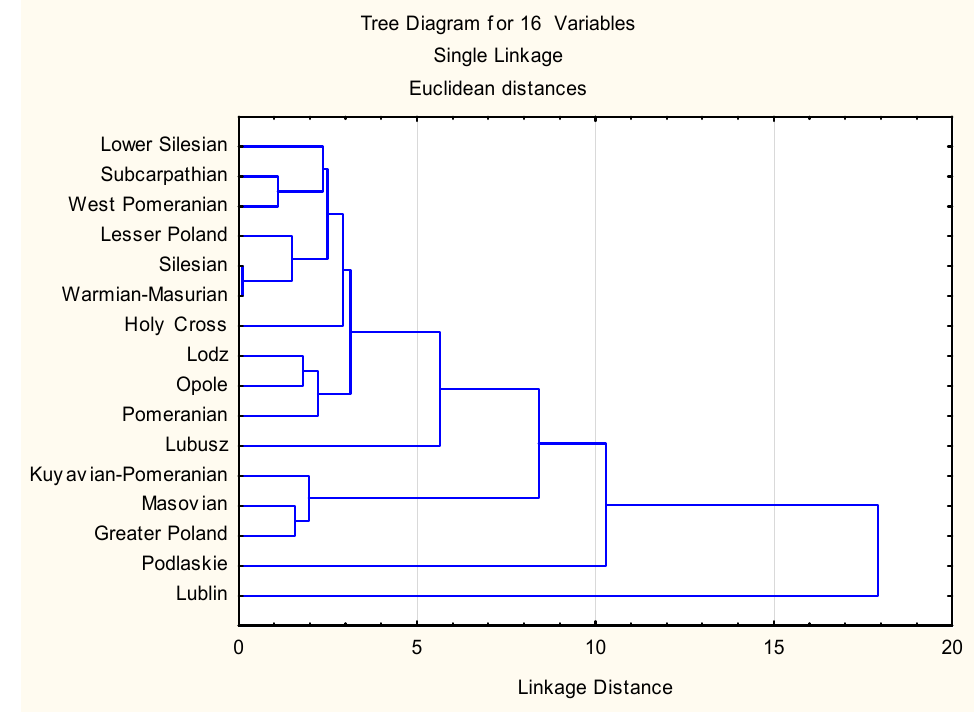
Figure 4. Increment of biogas production: DS—Lower Silesian; KP—Kuyavian-Pomeranian; LU—Lublin; LB—Lubusz; LD—Ł ó d´z; MP—Lesser Poland; MA—Masovian; OP—Opole; PK—Subcarpatian; PD—Podlaskie; PM—Pomeranian; SL—Silesian; SW—Holy Cross; WM—Warmian-Masurian; WP—Greater Poland; ZP—West Pomeranian. Spatial agricultural residue (crop and livestock) distribution is presented in Figure 5.